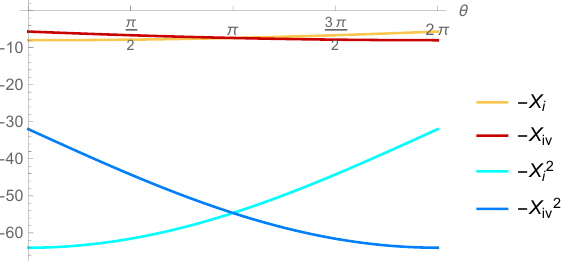
(b) Normalized critical chemical poten- tial ( m = ν = 1 ) above which the su- π perfluid phase is realized as a function of θ .